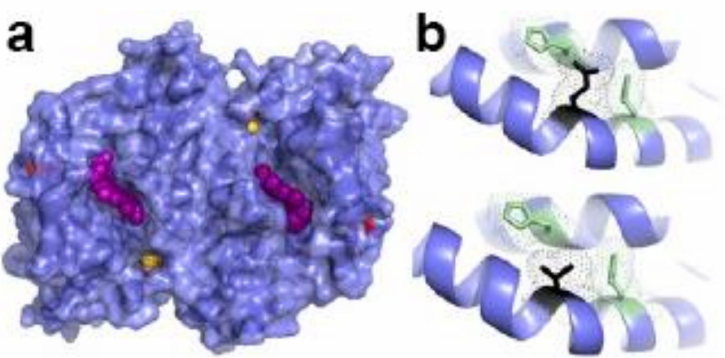
Figure 7. Structure of WT human FECH. ( a ) Surface representation of FECH dimer. Heme shown as purple spheres, [2Fe-2S] clusters yellow and orange spheres, and T116 as red surface. ( b ) Bottom, residues within hydrogen-bonding distance to T116 (black) include H86 and Q120, (green). Top, mutation of T116E (black), which would resemble phosphorylated T116 in size and charge is physi- cally too large to fit in the unphosphorylated structure and would, therefore, alter orientation and hydrogen bonding between the two helices shown. Figure created using PyMol (Schrödinger, Inc., New York, NY, USA) and PDB ID